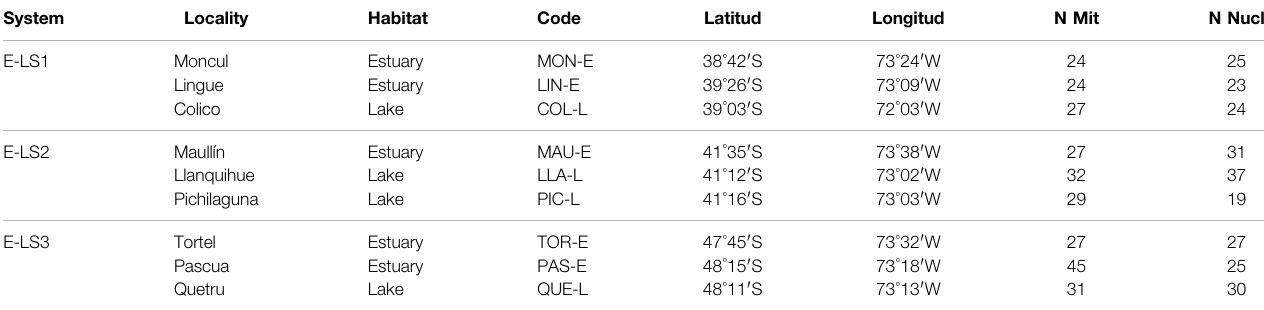
TABLE 1 | Galaxias maculatus sampling sites in the estuaries and lakes of western Patagonia, separated into the three systems analysed, with sample size for molecular analysis.